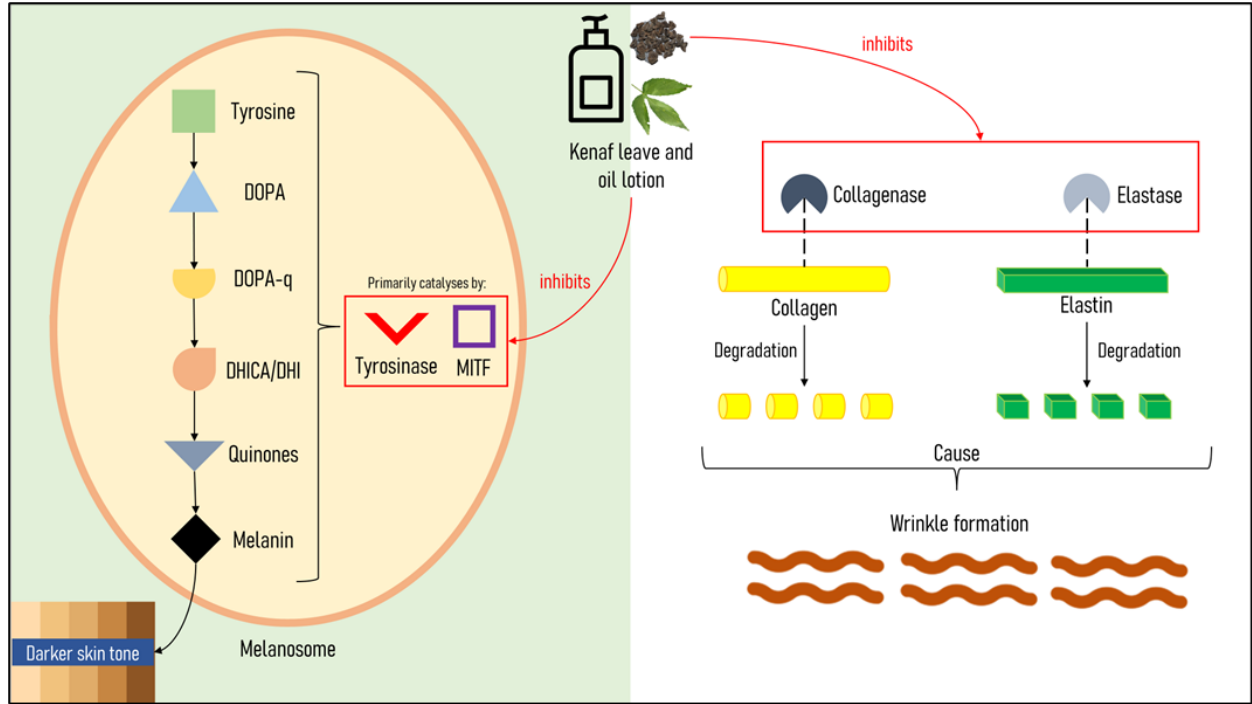
Figure 7. Graphical illustration of kenaf leave and oil-based lotion mechanism in addressing hyperpigmentation and ageing. DOPA: dihydroxyphenylalanine, DOPA-q: DOPA quinone, DHICA: 5,6-dihydroxyindole-2-carboxylic acid, DHI: 5,6- dihydroxyindole, MITF: microphthalmia-associated transcription factor.